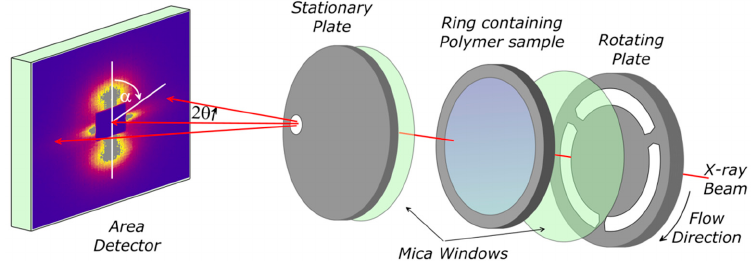
Figure 1. Schematic of X-ray shear cell system used in this work Adapted from [24] (Wangsoub, S.; Oiley, R.H.; Mitchell, G.R. Directed Crystallisation of Poly( ε -caprolactone) using a Low-Molar-Mass Self-Assembled Template. Macromol. Chem. Phys. 2005 , 206 , 1826–1839).